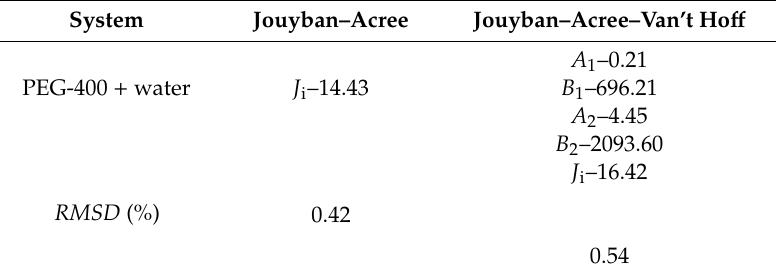
Table 6. Results of “Jouyban–Acree” and “Jouyban–Acree–Van’t Ho ff ” models for PPN in “THP + water” combinations.